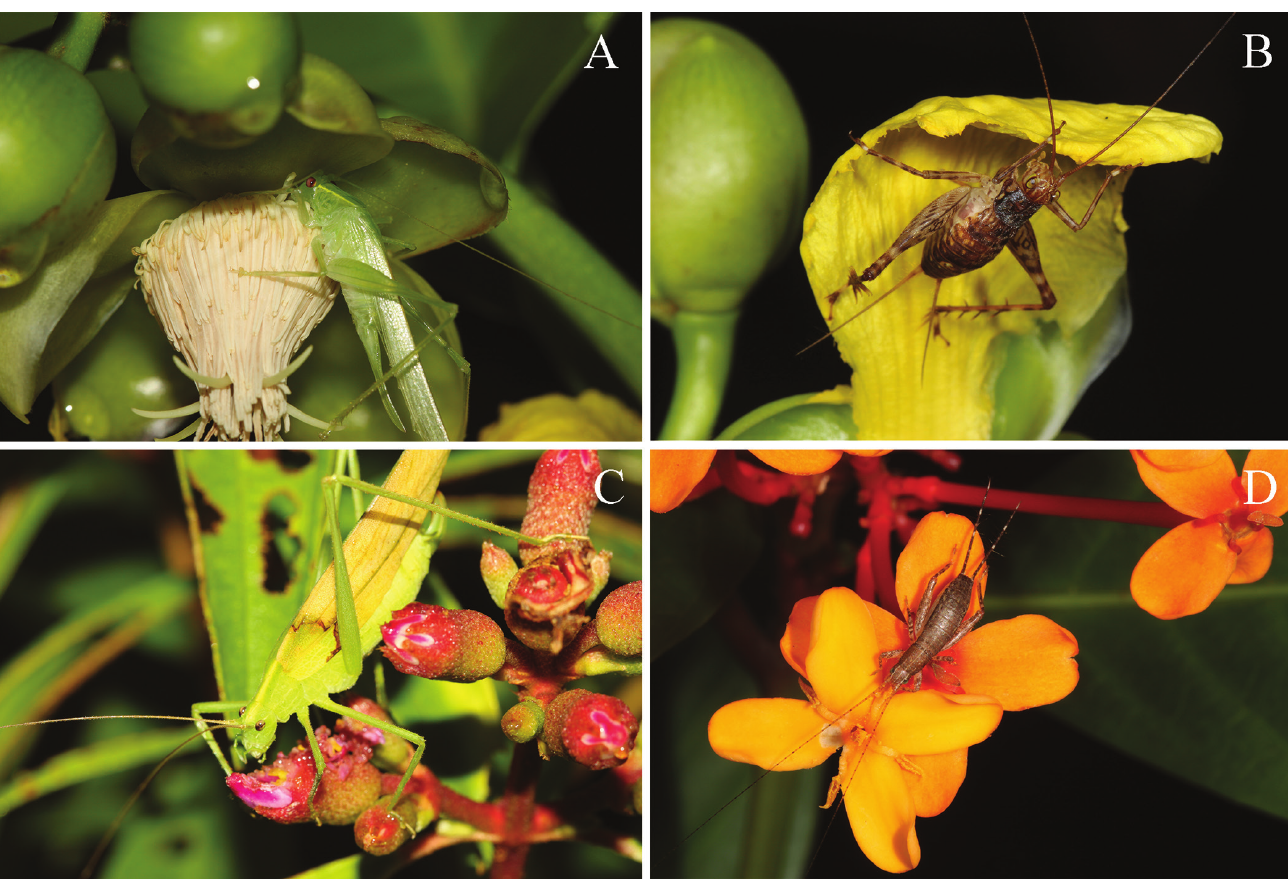
Fig. 5. Examples of flower-visiting orthopterans on native plant species: A. Alloteratura species on Dillenia suffruticosa in Singapore, B. Tremellia timah on Dillenia suffruticosa in Singapore, C. Elimaea carinata on Melastoma malabathricum in Singapore, and D. Ornebius rufonigrus on Ixora congesta in